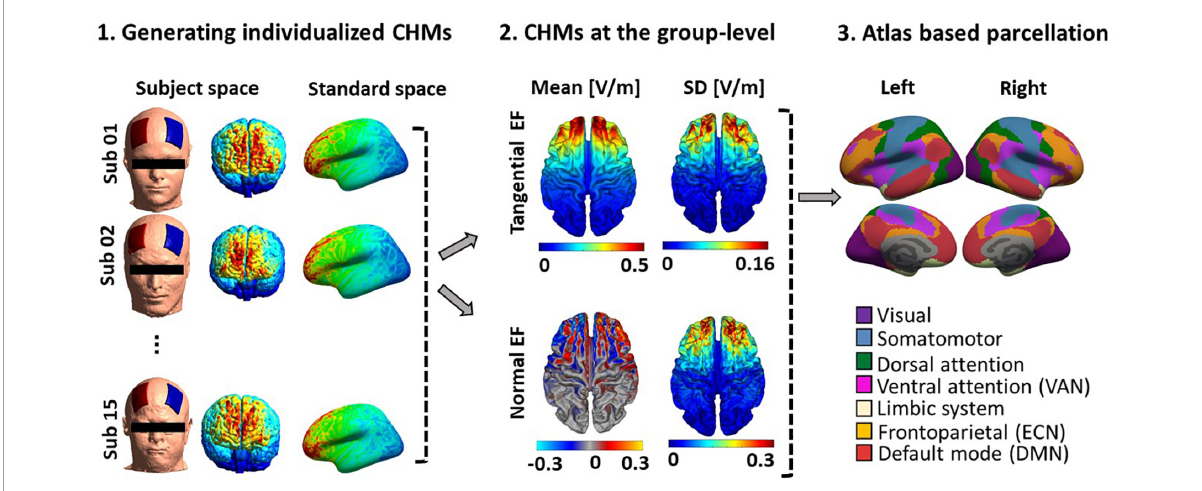
FIGURE3 Computational head model analysis. (1) Generating individualized CHMs: Head models were generated for all fifteen participants to calculate electric field distribution patterns using finite element modeling. Individualized CHMs were transformed to standard fsaverage space for group-level analysis. (2) Group-level analysis of CHMs: The mean and standard deviation (SD) of the electric field (for both tangential and normal components) across the population were calculated. (3) Atlas-based parcellation of CHMs (Yeo atlas): Yeo atlas parcellation of CHMs was used to calculate EFs in the main nodes of the three large-scale networks. See Supplementary Figure 1 to depict the Efs in the main nodes of ECN, DMN, and VAN. SD, standard deviation; CHM, computational head